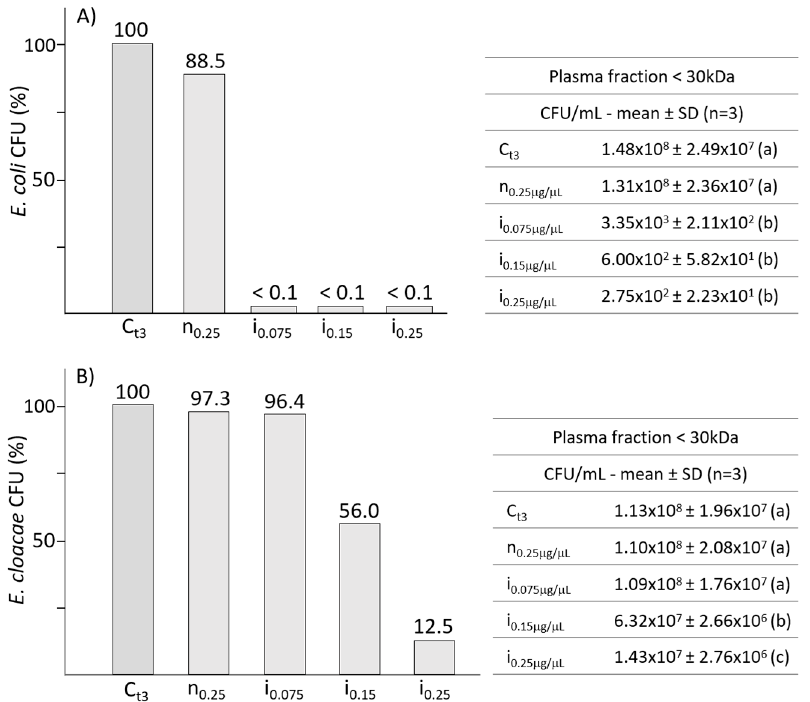
Figure 3. Panel ( A ) and ( B ) show the effects of various concentrations of silkworm AMPs on E. coli and E. cloacae , respectively. Tables on the right present the bacterial growths expressed as CFU/mL. Different letters within brackets (a,b,c) indicate significant differences ( p < 0.05, Tukey test). C: con- trol; n: plasma from not infected larvae; i: plasma from infected